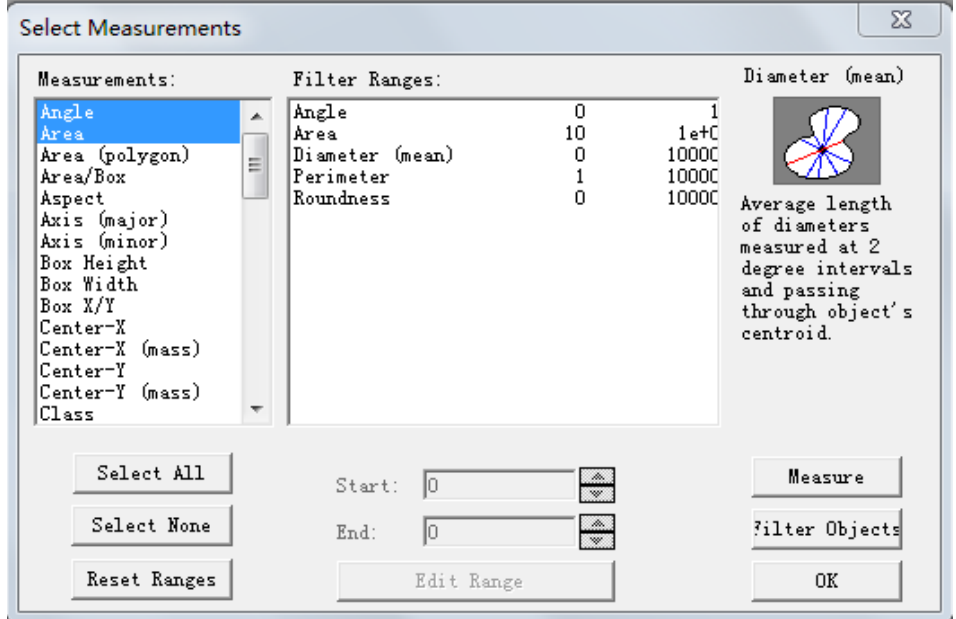
Figure 4. Image binarization processing.